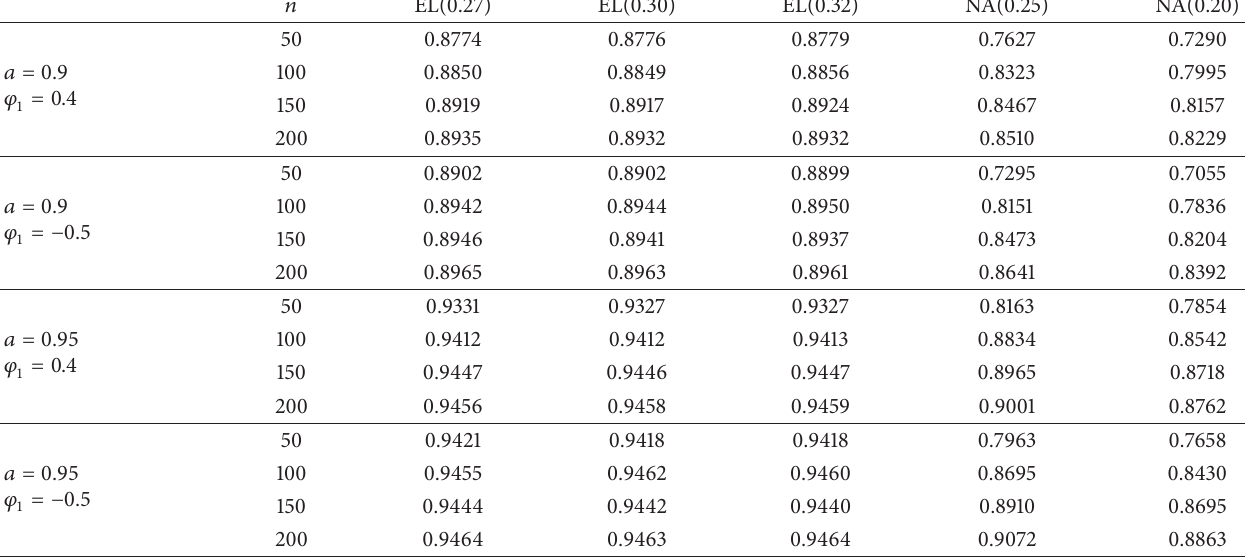
Table 2: The coverage probability of confidence intervals when 𝜀 𝑡 ∼ 𝑡 2 .